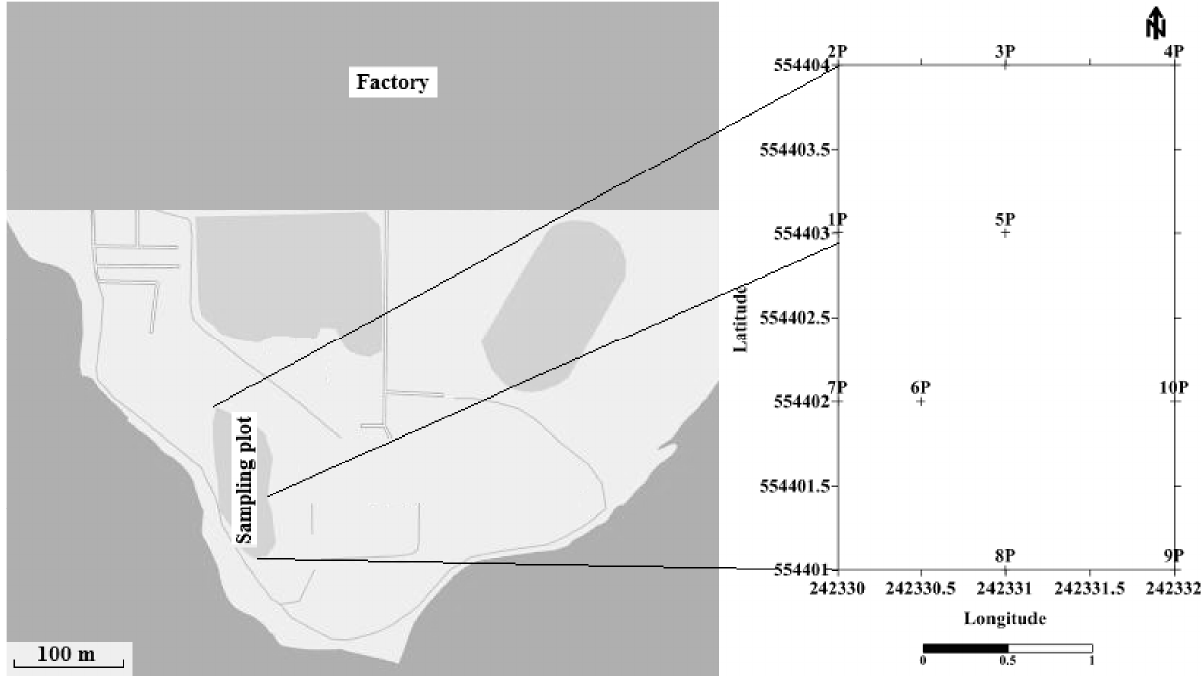
Fig. 2. Location of the contaminated study plot (55044´04´´N, 24023´30´´E). 1P, 2P, 3P etc. – trees sampled on the contaminated plot